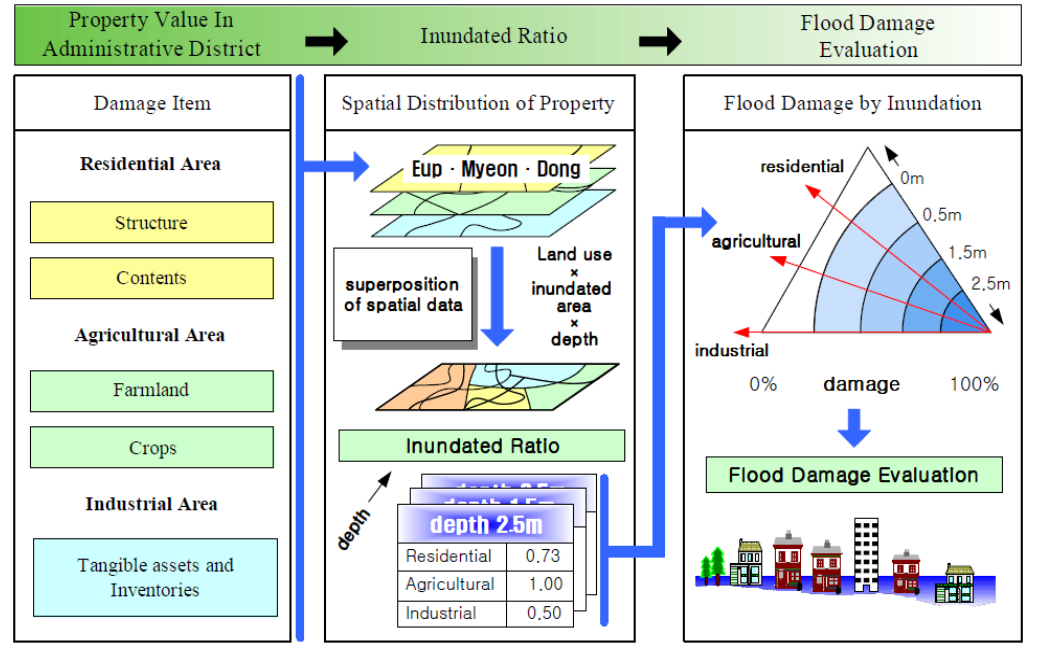
Figure 4. Procedure of the Multidimensional Flood Damage Analysis (MD-FDA).